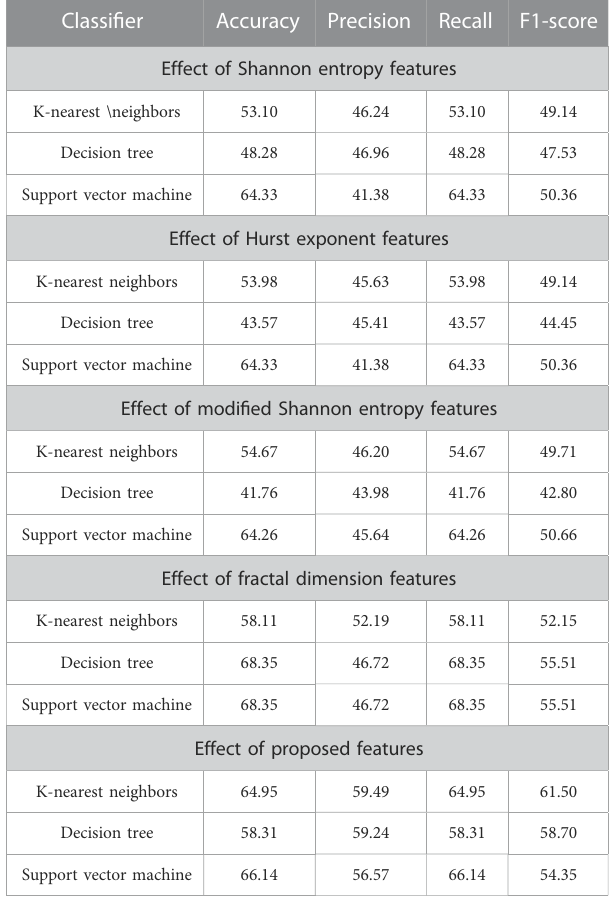
TABLE 8 Impact of existing and proposed features on the classi fi cation of essential genes for the AT, DOM, DR, HS, and MM species.